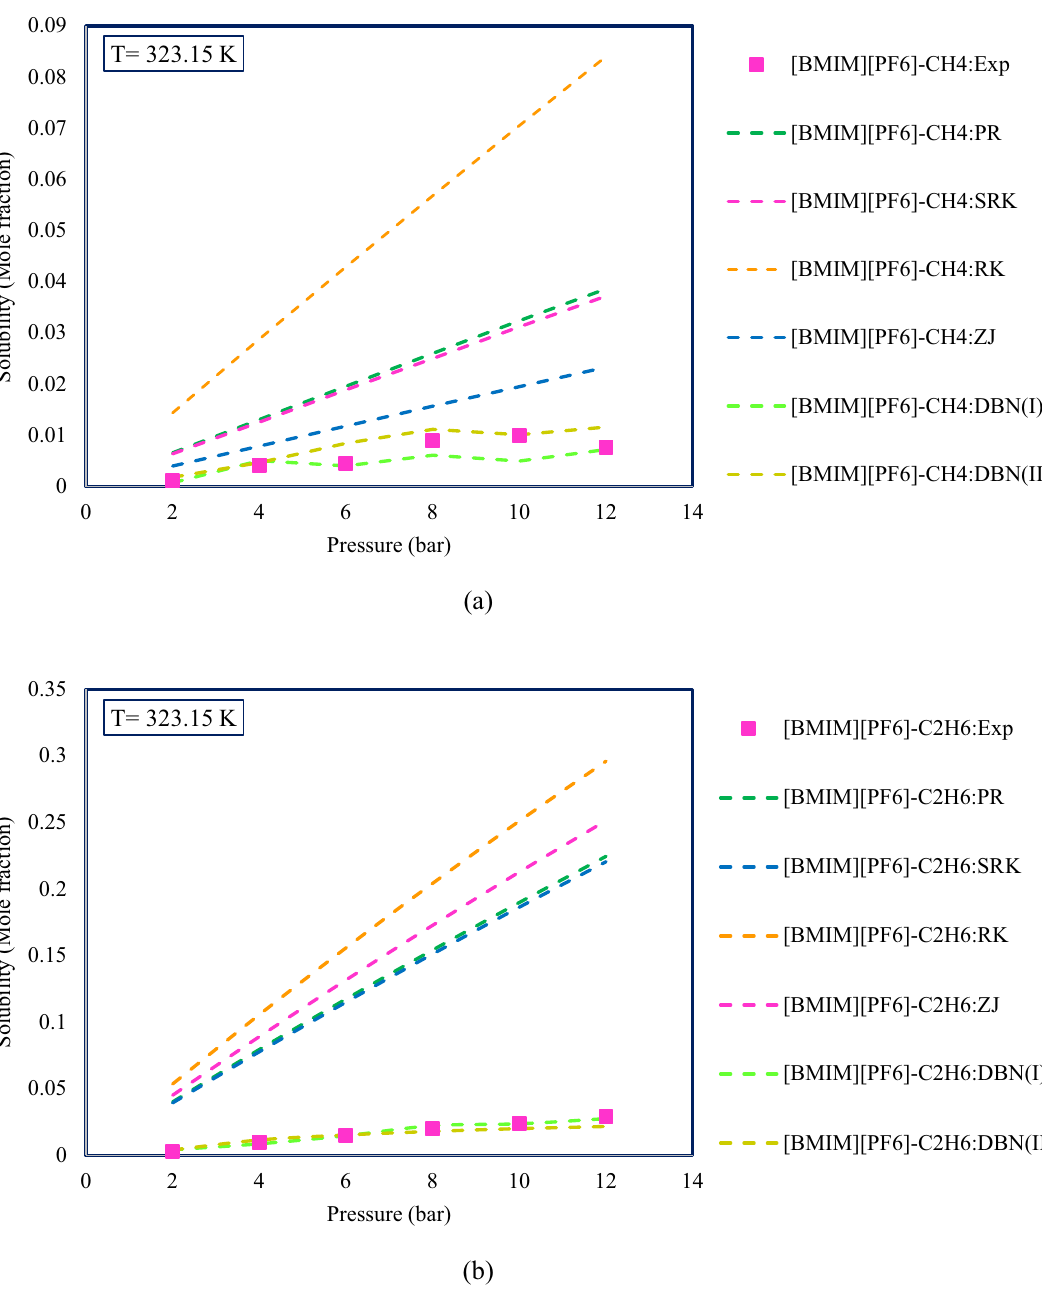
Figure 13. Comparison of the results of the DBN models and equations of state; ( a ) [BMIM][PF 6 ]-CH 4 , ( b )